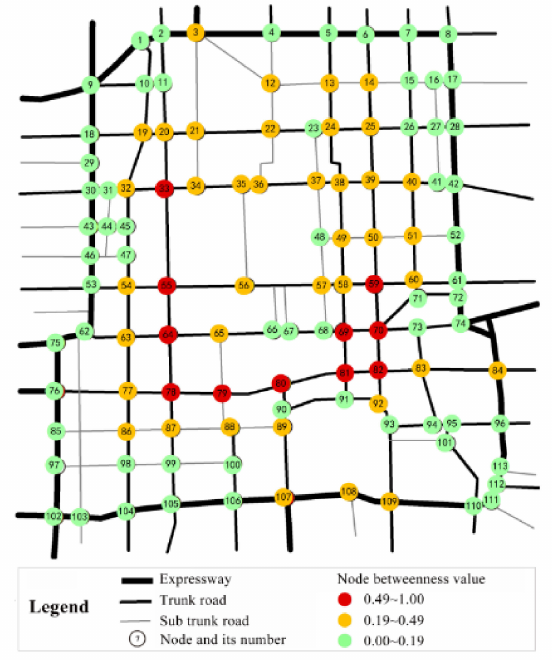
Figure 7. Spatial distribution of node